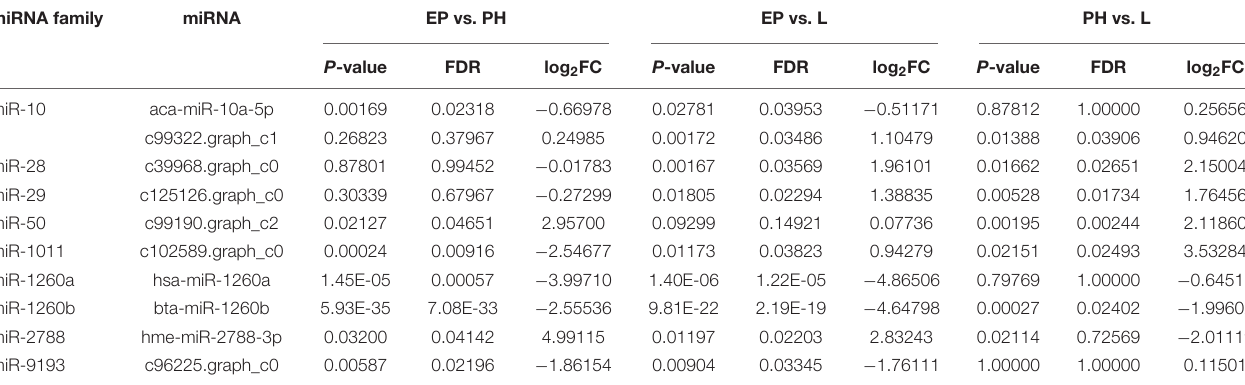
TABLE 4 | Specific information on potential miRNA related to embryonic development. miRNA